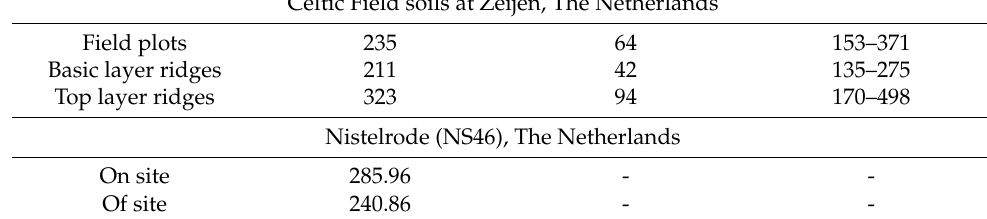
Table 6. Comparison of P values: (i) Voorthuizen archaeological site cultural layer (VN-8–VN-11) (mg P kg − 1 dry soil, XRF, and real total); (ii) Natural heathland soils and Celtic Field soils at No- ordseveld (Zeijen, The Netherlands) (mg P kg − 1 of dry soil, detected spectrophotometrically using molybdene blue, [14]); and (iii) Nistelrode (NS46) (mg P kg − 1 , detected using ICP-OES [22]). Object Mean Standard Deviation Spread Voorthuizen, The Netherlands VN-8 149 79 - VN-9 299 5 VN-10 389 Natural heathland soils at Noordseveld, Zeijen, The Netherlands Ah-horizon podzol